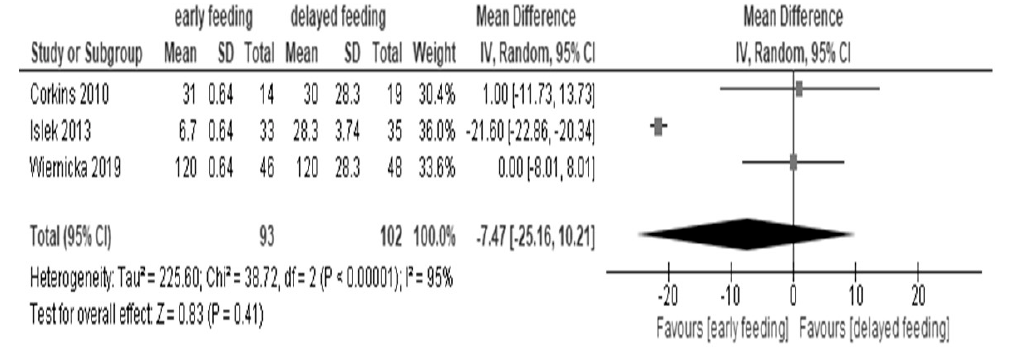
Figure 3. Forest plot of hospital stay (hours).